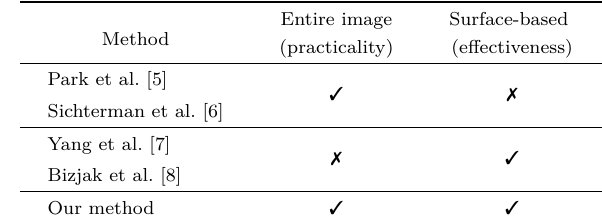
Table 1 Comparison of related works and our